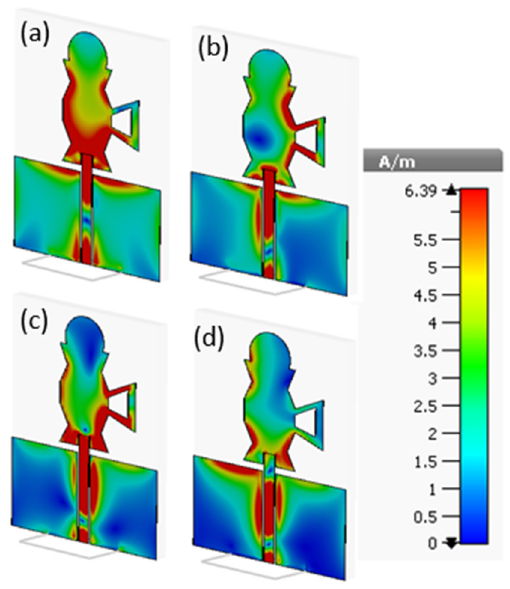
Figure 5. Surface current density ( a ) at 3.5 GHz, ( b ) at 4.1 GHz, ( c ) at 8 GHz, ( d ) at 10.5 GHz.